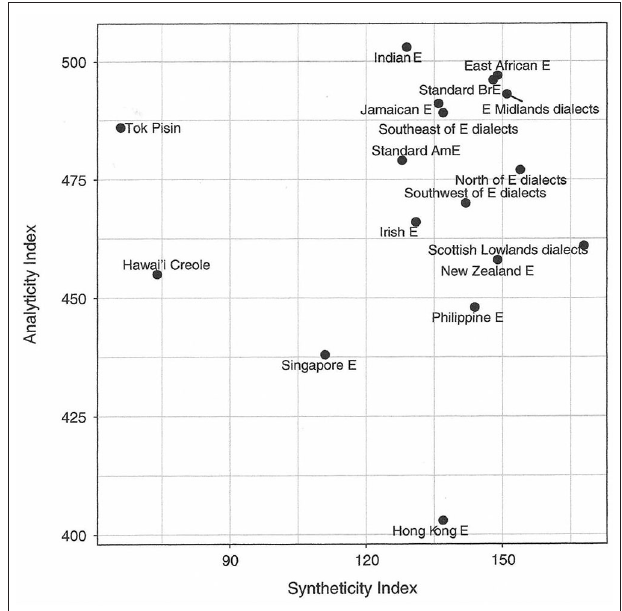
FIGURE 25 | Szmrecsanyi and Röthlisberger’s plot for syntheticity and analyticity among world Englishes (from Szmrecsanyi and Röthlisberger, 2020, p. 548; after Siegel et al., 2014; Figure 2 ).